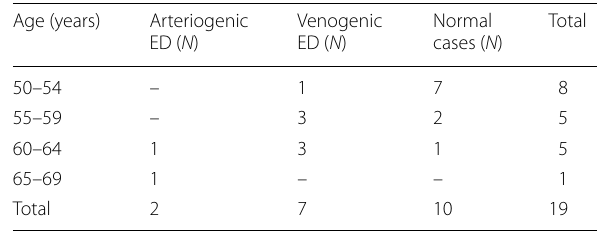
Table 4 Relationship between age and PSV of the CAs among the entire participants (ANOVA)